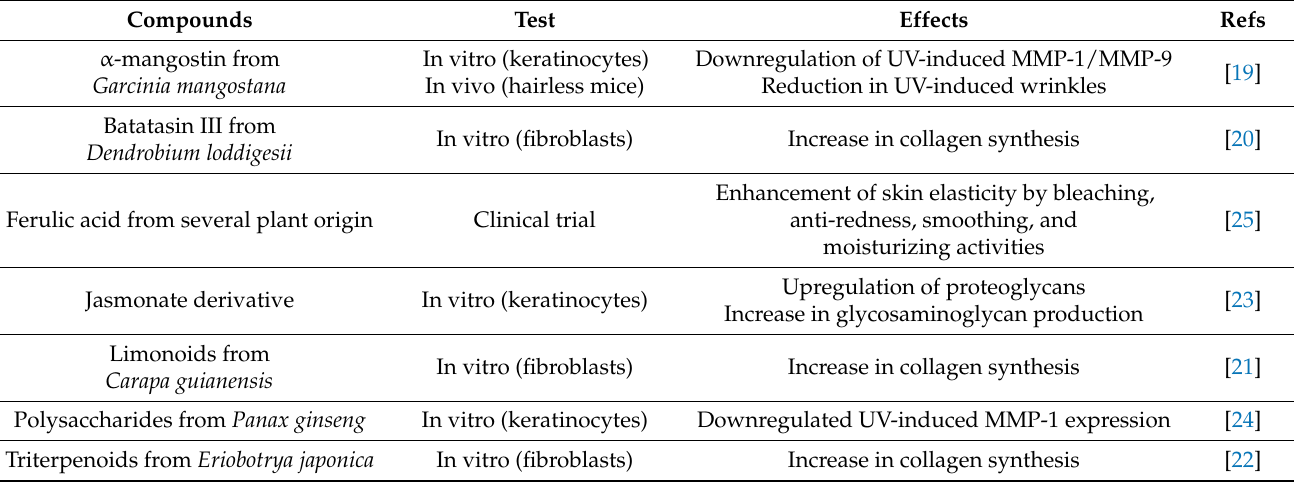
Table 1. Main isolated natural compounds with anti-aging effects by acting on skin elasticity and wrinkle